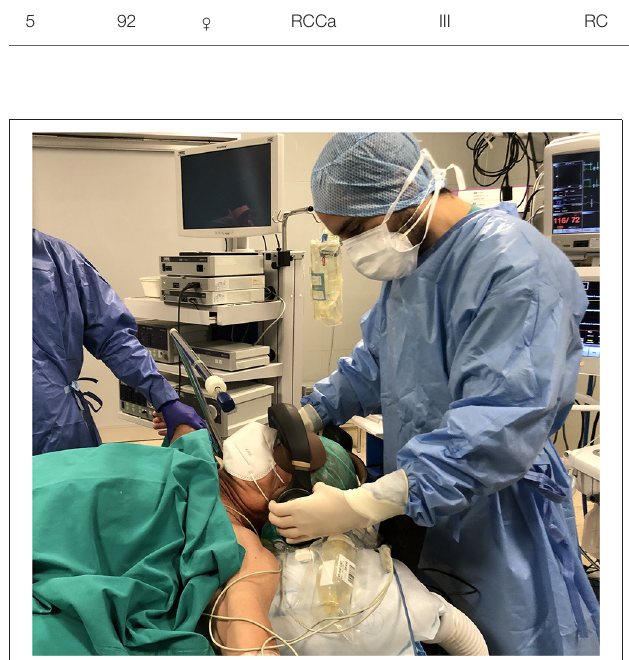
FIGURE 1 | Patient wearing the device (preoperative snapshot).